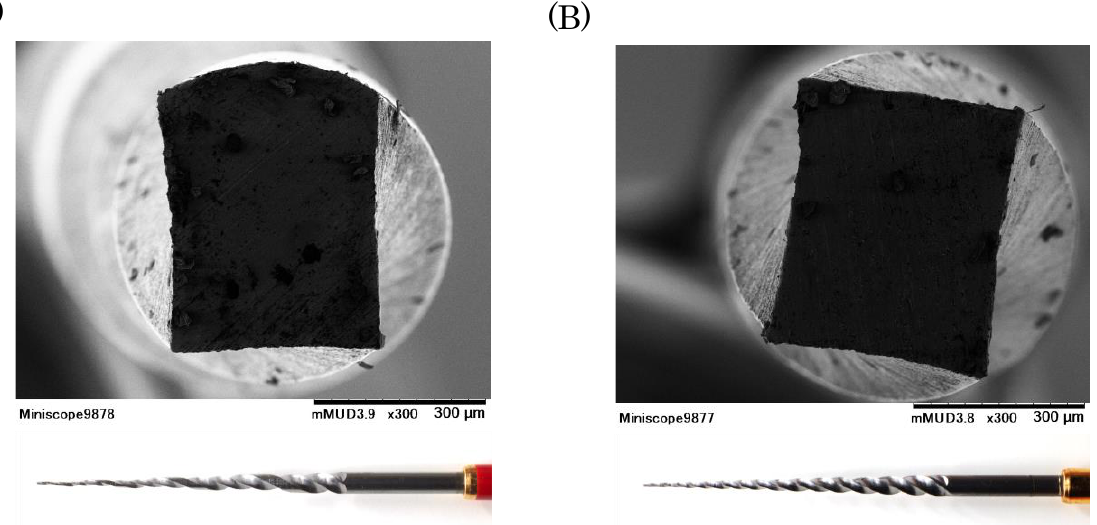
Figure 1. Cross-sectional shape and cutting portion of the JIZAI instrument (A) and the non-landed experimental instrument (B).